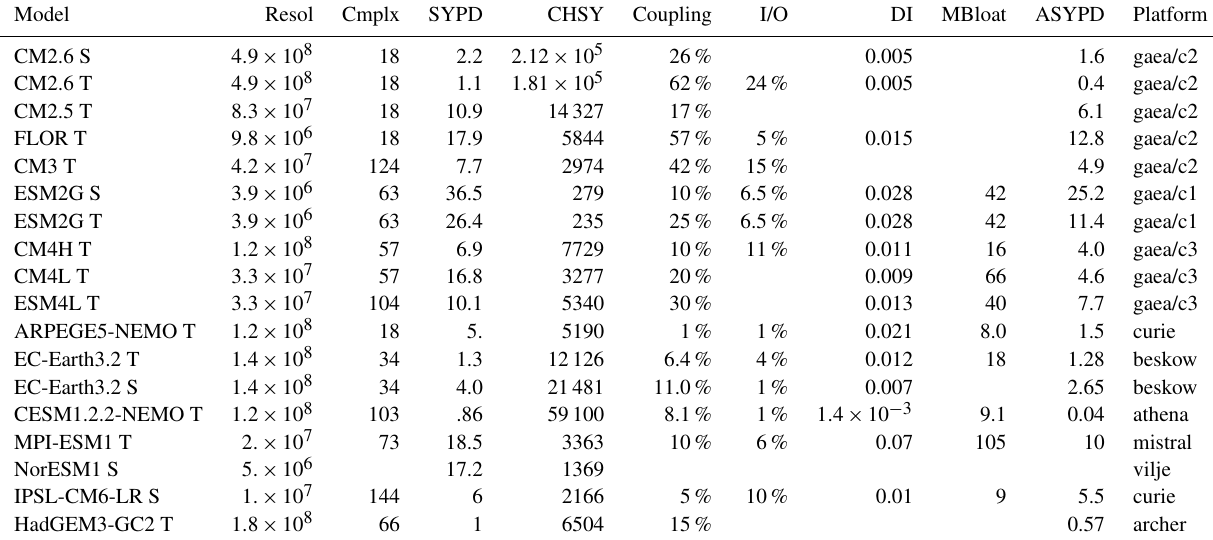
Table 1. Results from several ESMs. Not all the cells are currently filled, but we propose to collect these systematically in the full-scale CPMIP project. See the text for an explanation and a discussion of the terms.